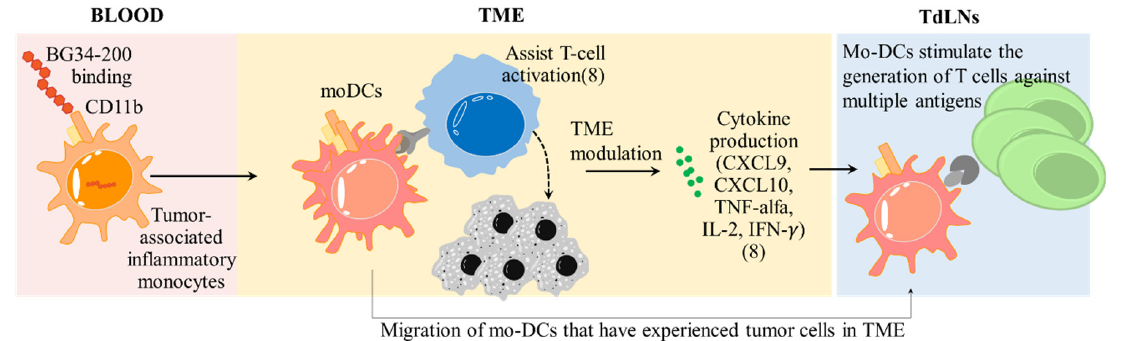
Figure 7. Sequential immune activation induced by BG34-200 IV administration in the context of advanced melanoma. In peripheral blood, BG34-200 IV administration triggers direct entry of compound to the tumor-associated inflammatory monocytes (CD11b + CCR2 + PU.1 low ) and potentiates the cells to be CD11b + CCR2 + PU.1 high . The BG34-200 + CD11b + CCR2 + PU.1 high cells migrate to TME and differentiated into mo-DCs, resulting in alteration of tumor microenvironment, as evidenced by ref. [8] and this current study. The mo-DCs are found to migrate to TdLNs, where they stimulate the generation of tumor-specific T cells. The BG34-200-induced antitumor effect is unique in that the source of tumor-specific T cells is derived from the sentinel draining lymph nodes, which is the natural site of the immune response against pathogens as well as cancer. This can potentially improve the T cells that are naturally primed against defined and undefined tumor antigens, leading to a broader response to tumor antigens.